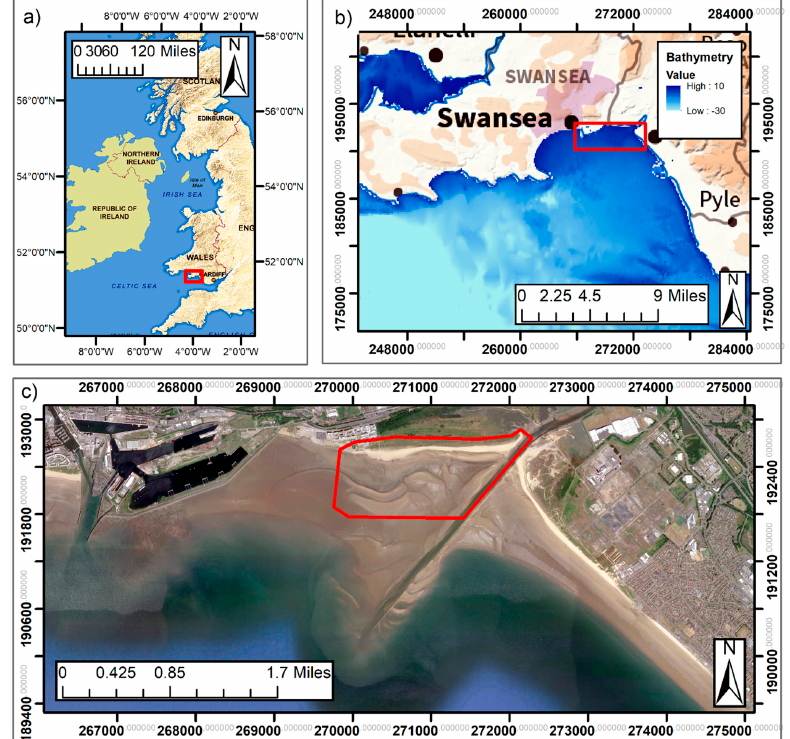
Figure 1. ( a ) A map of Great Britain with the location of panel b marked in red; ( b ) The Swansea Bay area showing local bathymetry with the location of panel c marked in red; ( c ) An aerial photo showing the surroundings of Crymlyn Burrows with the drone survey area marked. Map contains OS data © Crown copyright and database right (2020), reproduced under Open Government Licence. Aerial imagery copyright 2020 Google; Data SIO, NOAA, US Navy, GEBCO.